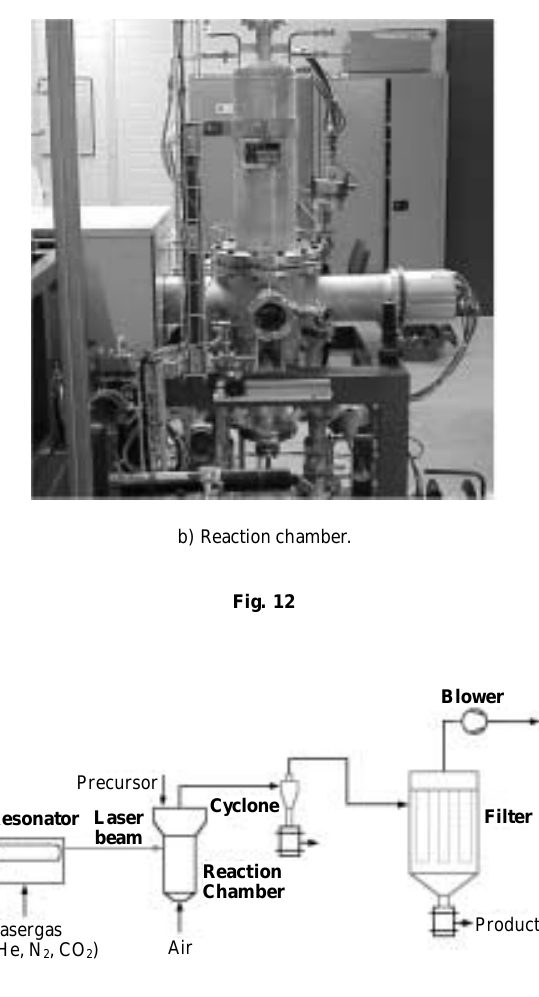
Fig. 15 TEM image of